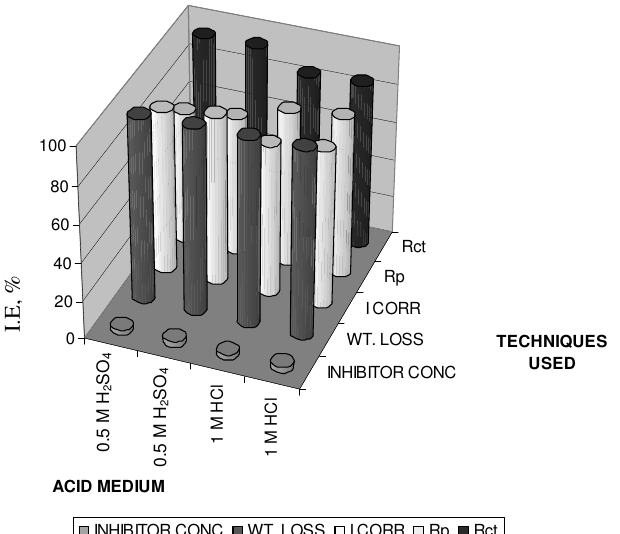
Figure 5. Comparison between conventional method and electrochemical techniques of palmyra palm shell extract in 0.5 M H